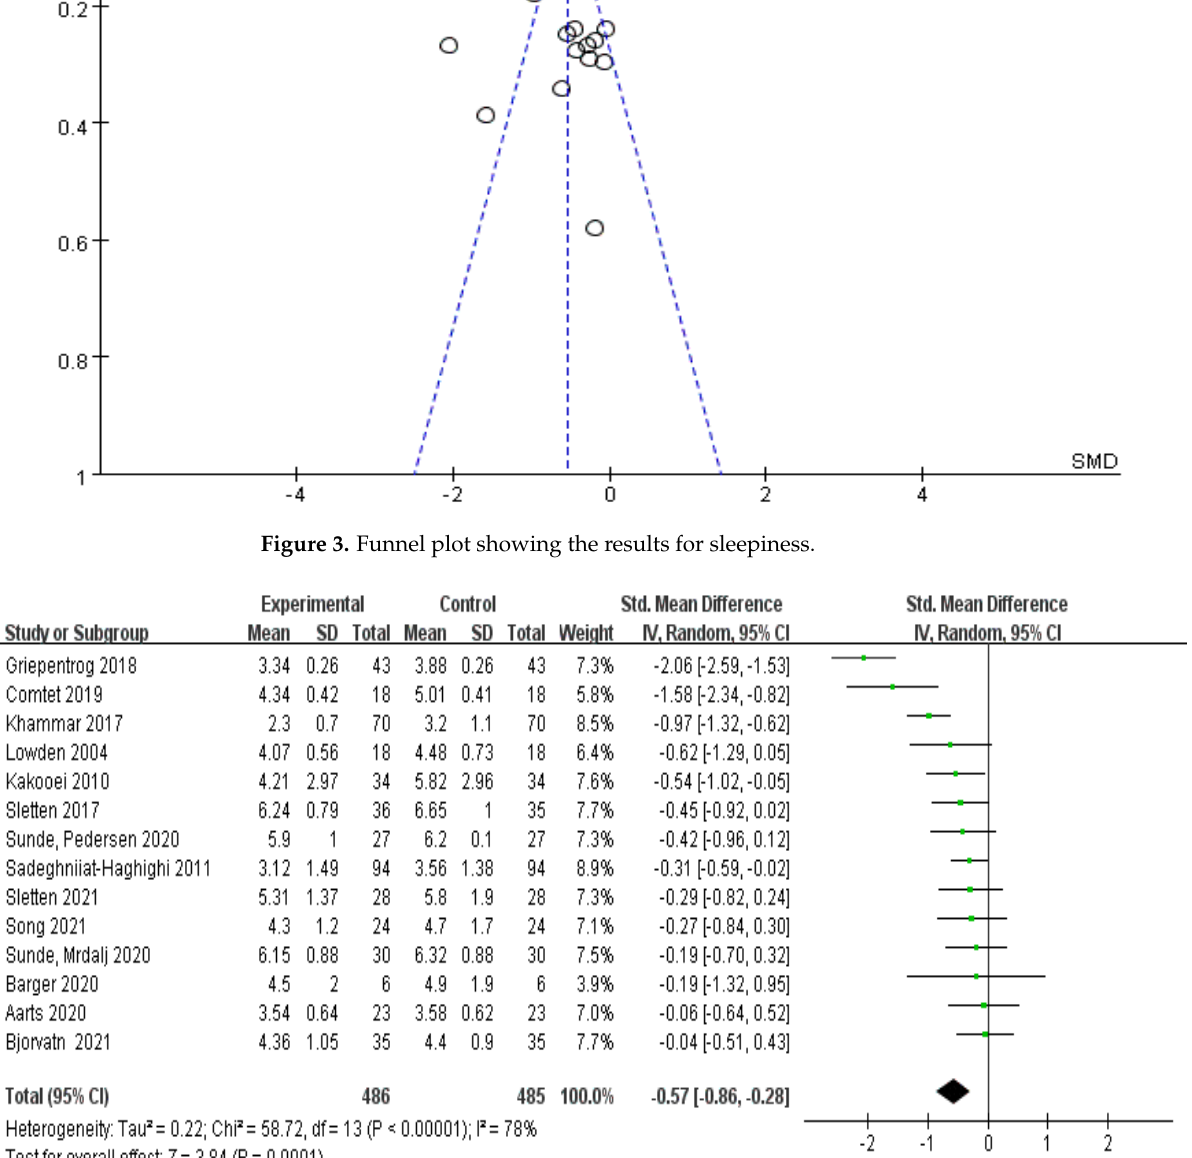
Figure 3. funnel plot showing the results for sleepiness.